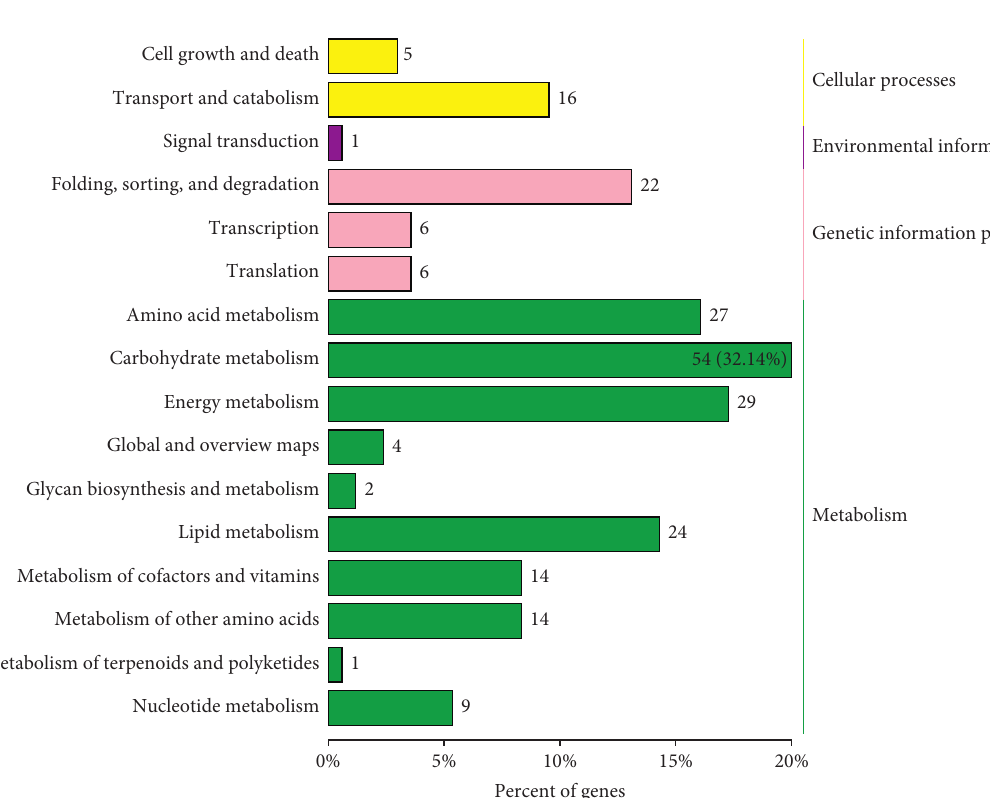
Figure 5: KEGG categorization of differentially expressed genes in P. expansum